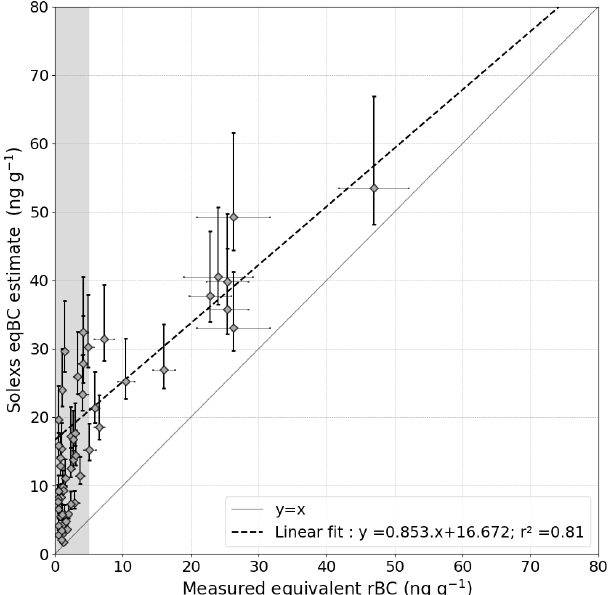
Figure 11. Comparison between measured and estimated eqBC concentrations for all the ZOIs with concomitant LAP measure- ment. The grey shading corresponds to the zone below the sensi- tivity limit of our method (i.e. 5ngg − 1 ). Error bars show how un- certainties on the enhancement parameter of ice B affect the LAP retrieval